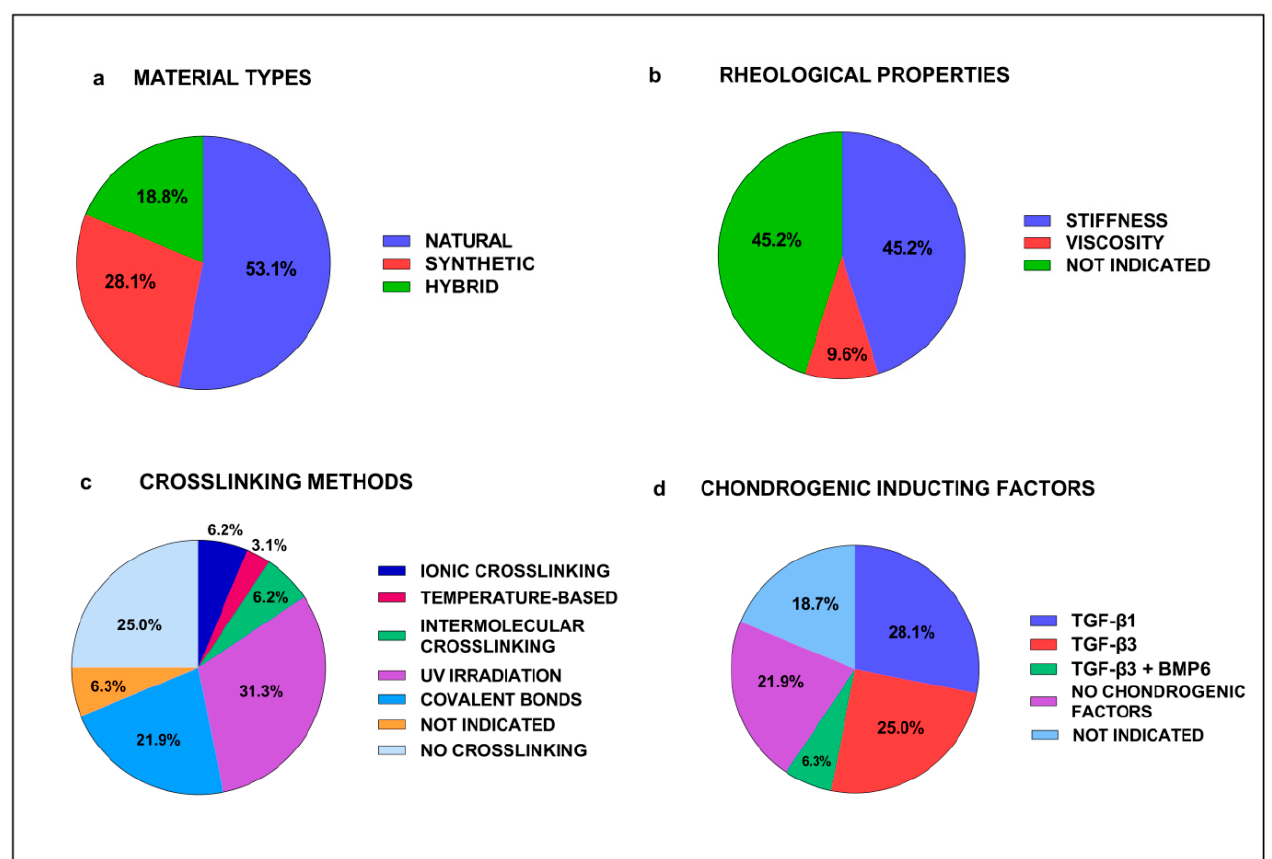
Figure 3. Major characteristics of in vitro studies: ( a ) material types; ( b ) rheological properties; ( c ) crosslinking methods; ( d ) chondrogenic inducting factors.